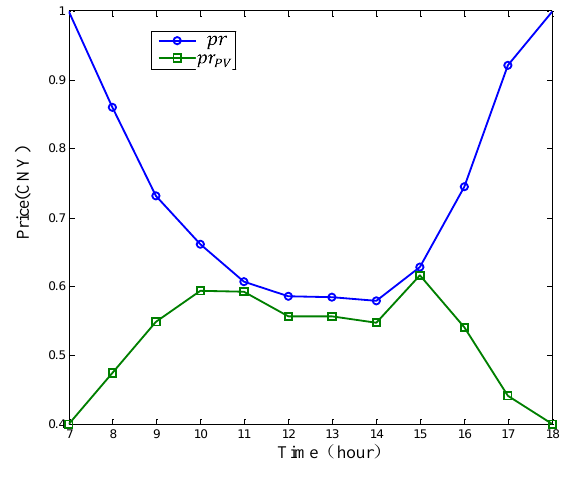
Figure 7. Internal prices of the PVC.